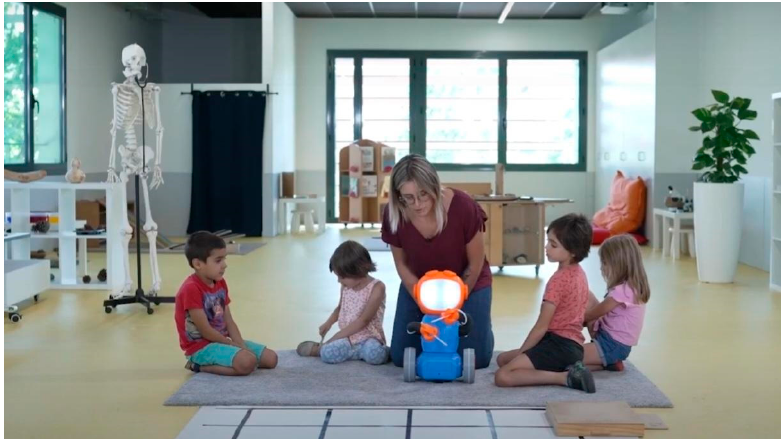
Figure 15. Testing 3D Qui-Bot in early ages (source Fibracat [42]).